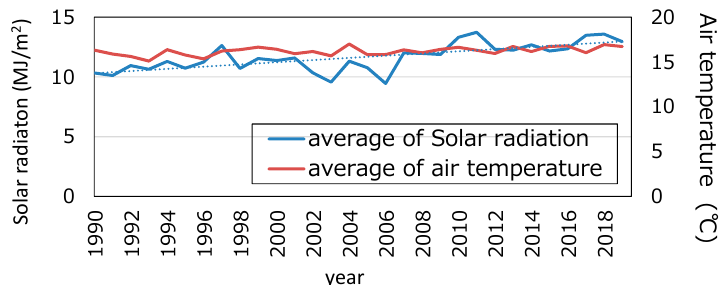
Figure 13. Trends in annual averages of solar radiation compared with those of air temperature. Solar radiation: annual averages of daily total amount of solar radiation at two General Sta. (Tajima from 1990–2006; Tajima and Saiwai from 2007 to 2019). Air temperature: same as Figure 9.